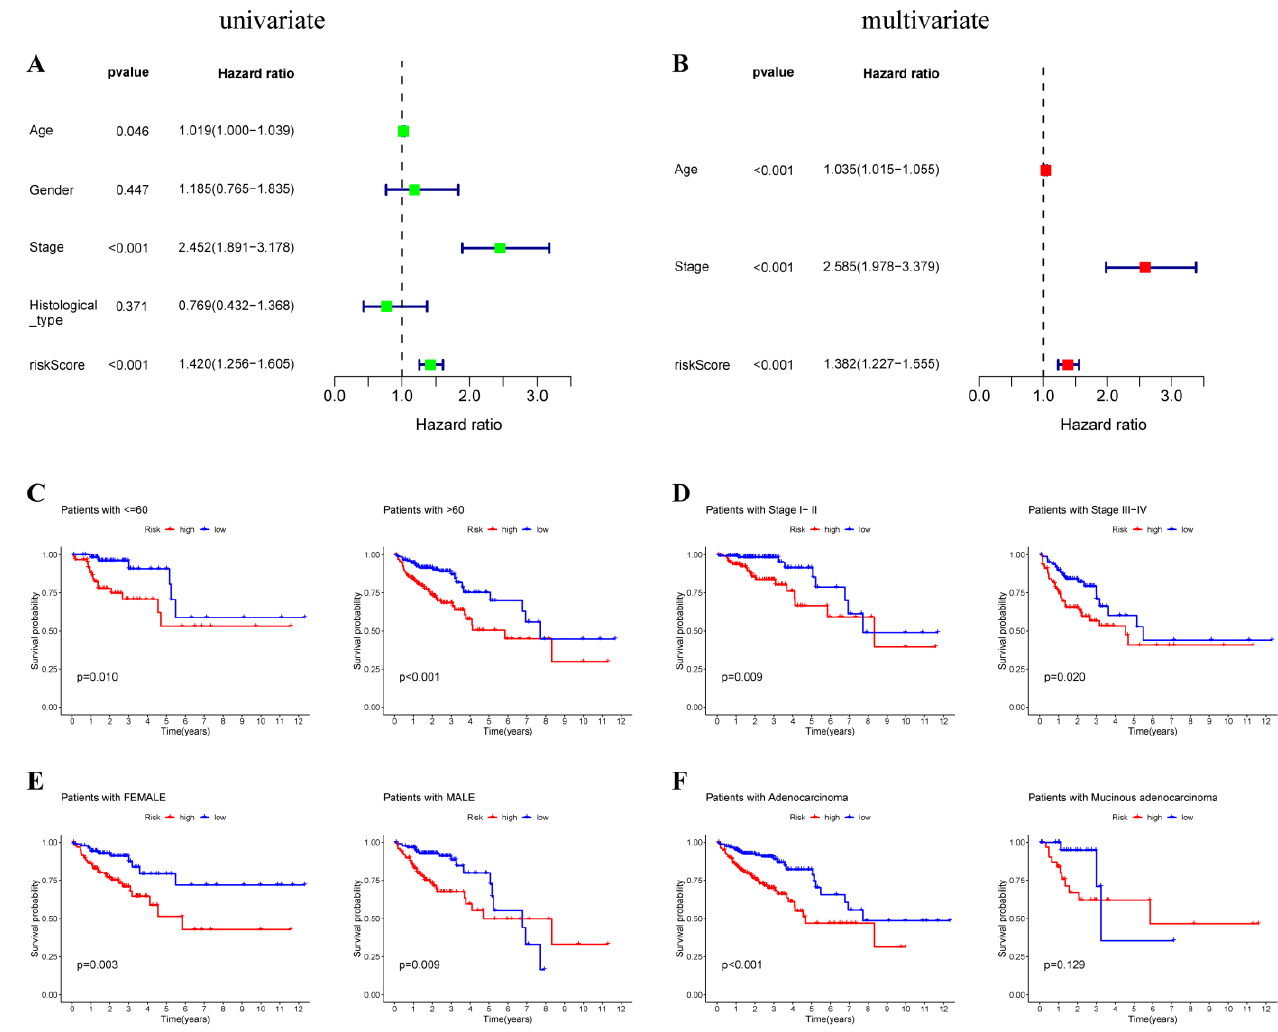
Figure 3. Subgroup analysis of the prognostic value of risk score in COAD patients. Identification of independent factors by univariate ( A ) and multivariate ( B ) Cox regression analysis. Prognostic value of risk score in patients with different age ( C ), different stage ( D ), different gender ( E ) and different histological_types ( F ).